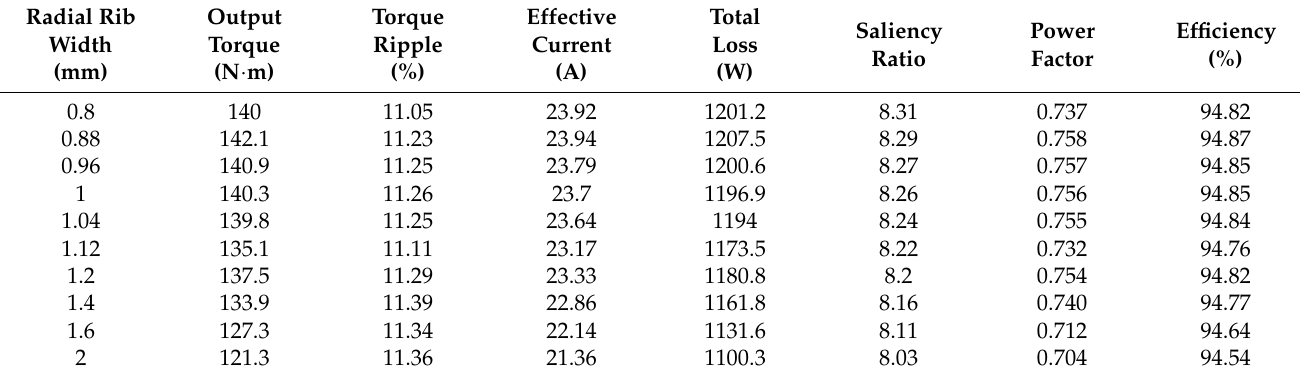
Table 7. Analyzes on radial rib